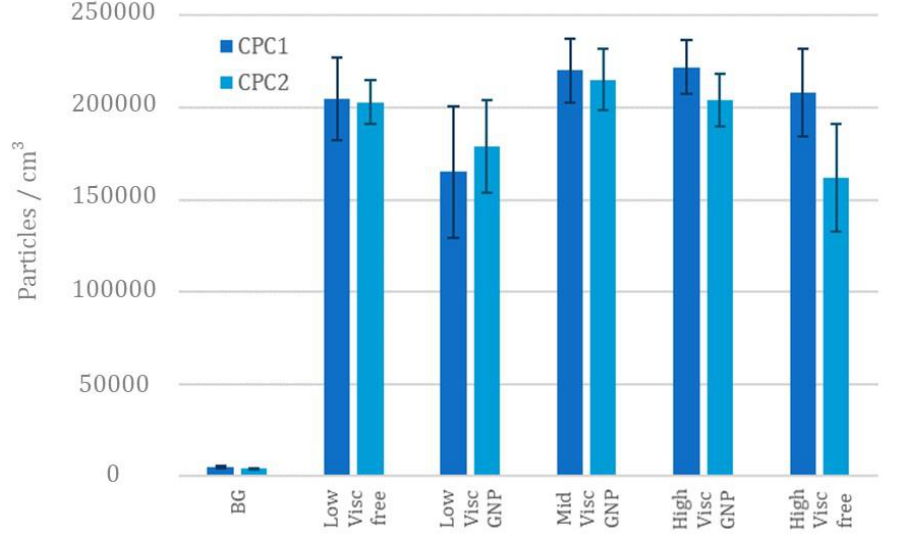
Figure 8. Comparison of the mean PNC of both CPCs.